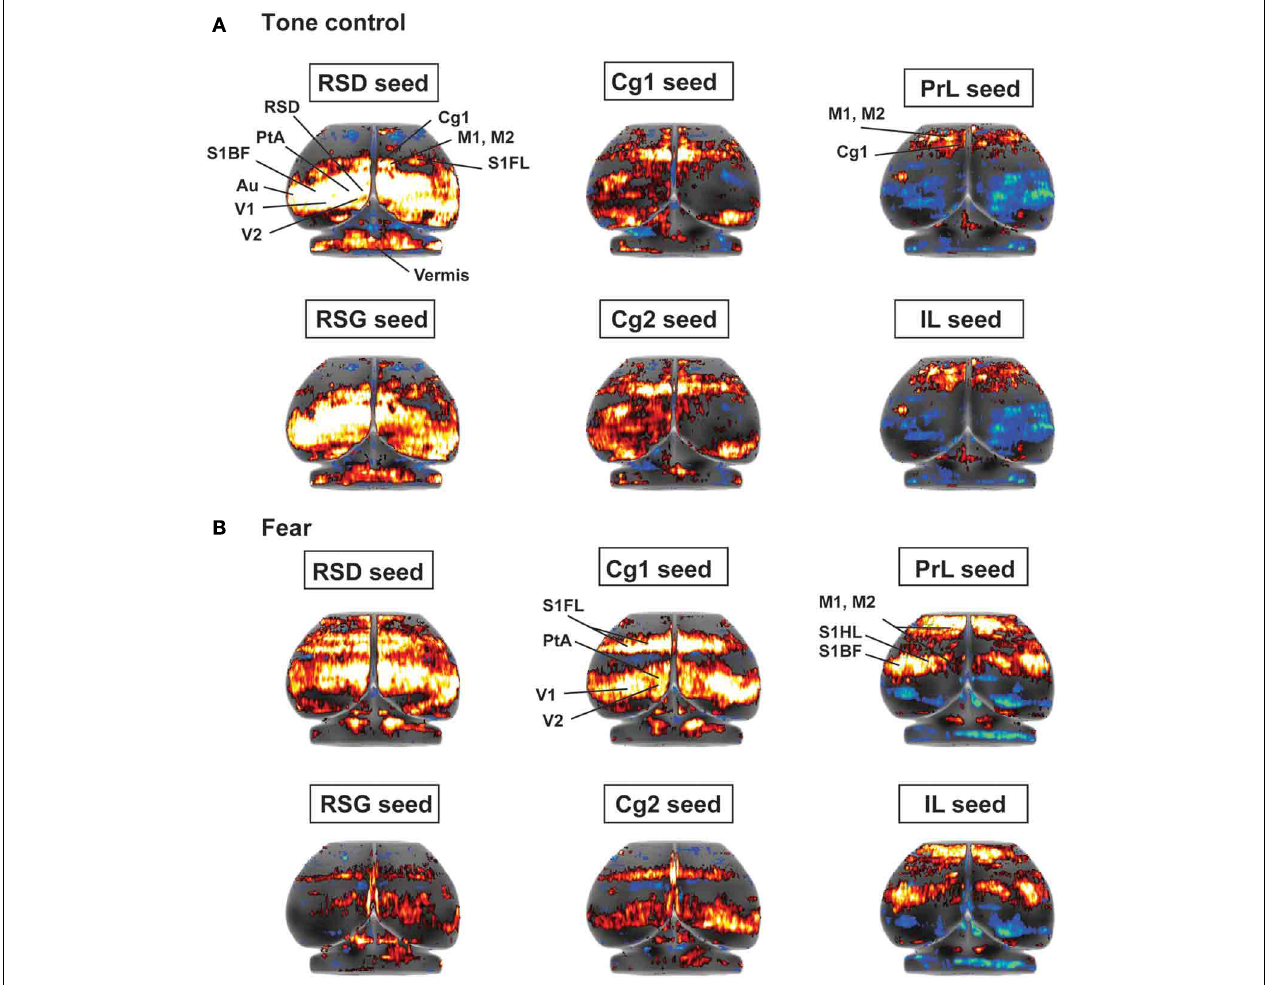
FIGURE 6 | Functional connectivity of the cortical midline structures (CMS) with the cerebral cortex. (A) Control mice. (B) Fear-conditioned mice. Results of seed correlation analysis are plotted in a top-down view of the cerebral cortex. Voxel-wise correlation coefficients with the CMS seeds are color coded, with red and blue representing positive and negative correlation, respectively. Abbreviations for cortical structures: Au,